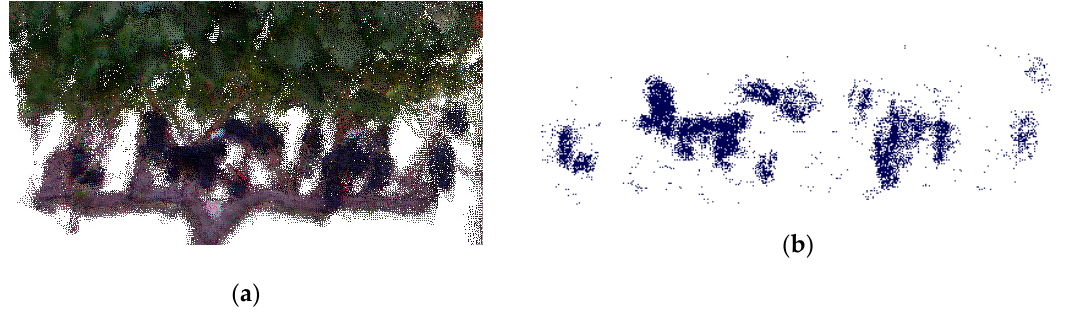
Figure 8. ( a ) The Kinect point cloud for an LR-treated vine (1E—east side) and ( b ) the segmented point cloud of the same vine.